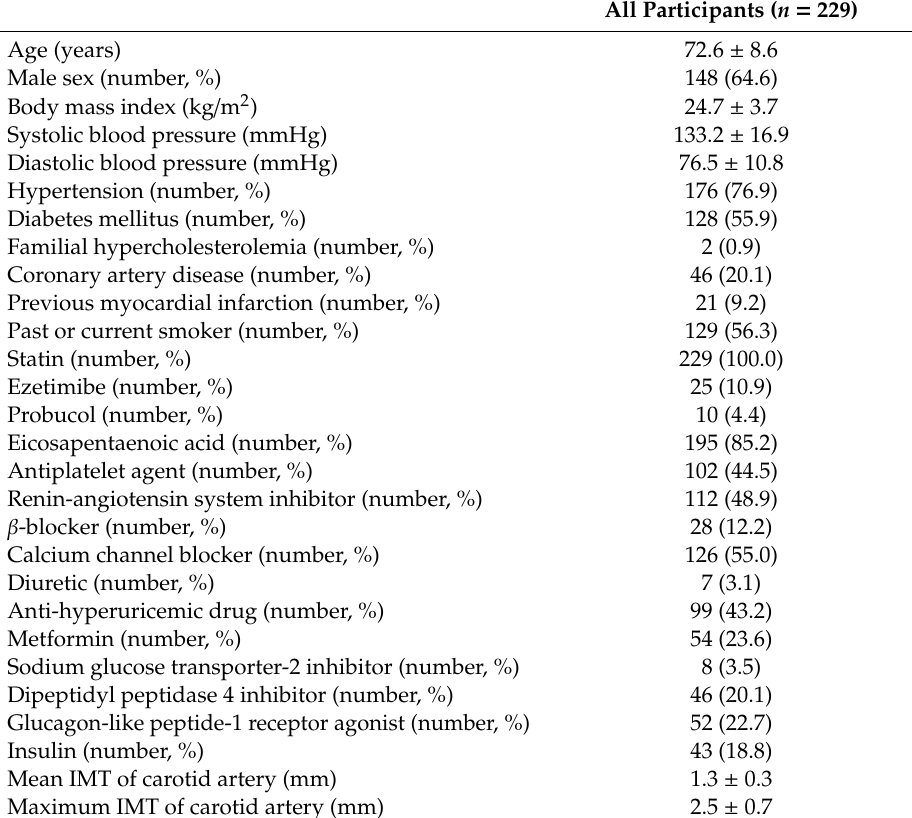
Table 1. Participant characteristics and medication at the initiation of